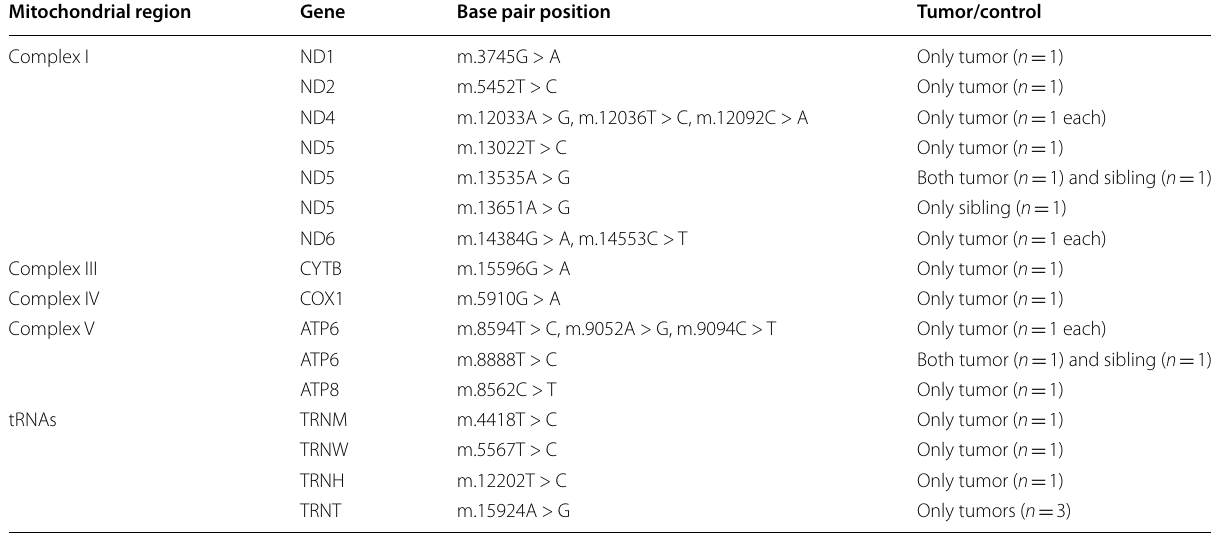
Table 4 List tabulating the 21 new, missense variants, with unassigned dbSNP IDs, in different regions (column 1) encoding genes (column 2) of the mitochondrial genome at various base positions (column 3) and their presence/absence in the number of tumor and control samples (column